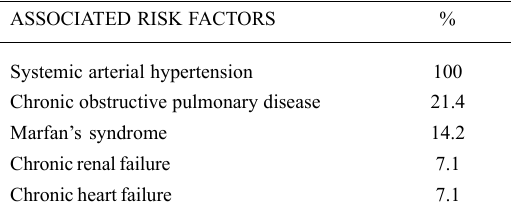
Table 1. Risk factors associated to the disease ASSOCIATED RISK FACTORS % Systemic arterial hypertension